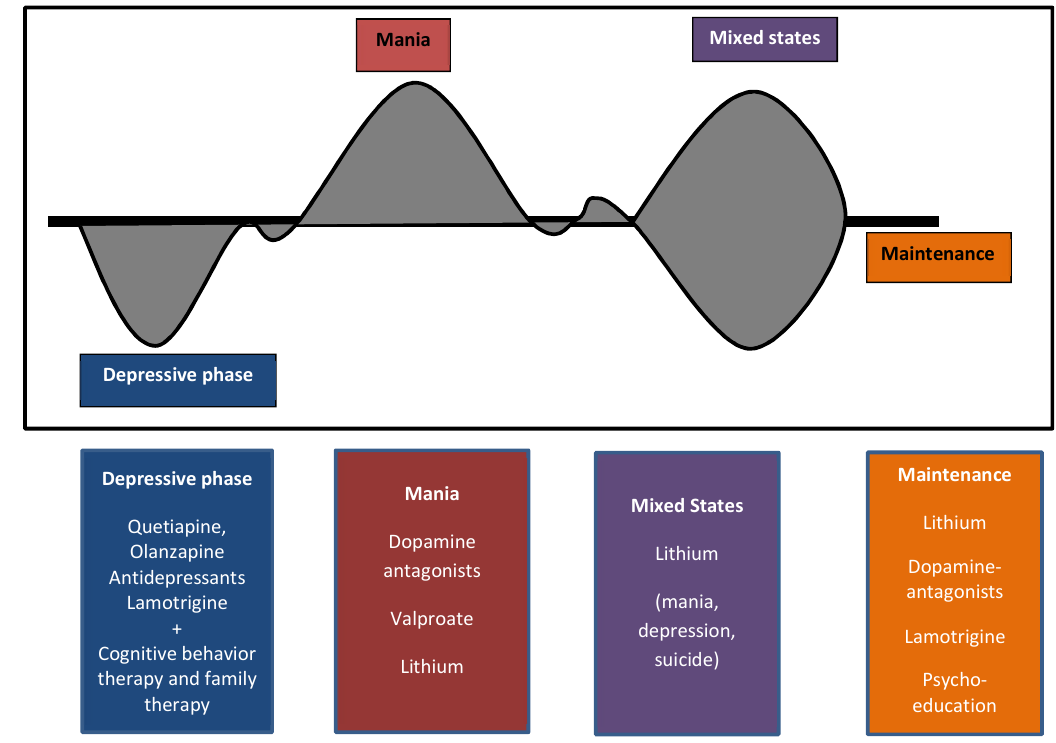
Figure 2: Treatment during the different phases of bipolar illness